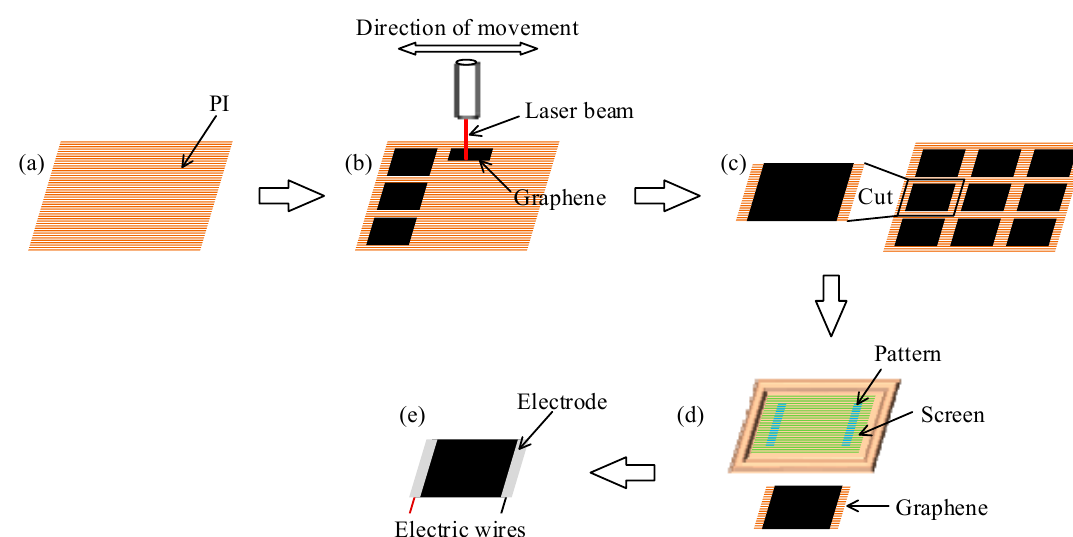
Figure 6. Fabrication process of the thermoacoustic speaker. ( a ) PI substrate; ( b ) Laser printing; ( c ) Cut the PI film; ( d ) Screen printing conductive silver glue; ( e ) Adding wires.